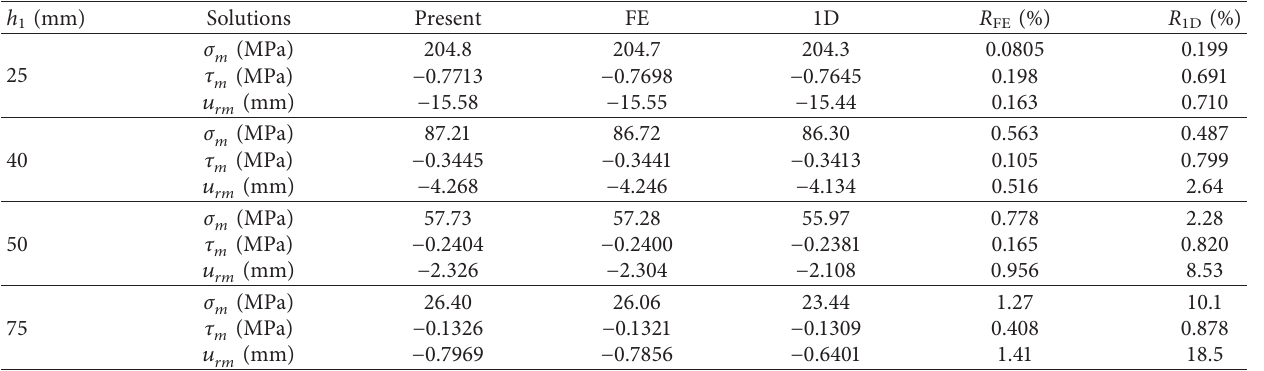
Table 4: Comparisons of FE results with the present results for different length-to-thickness ratios a/H when t � 104 ( s ), respectively. h 1 (mm)